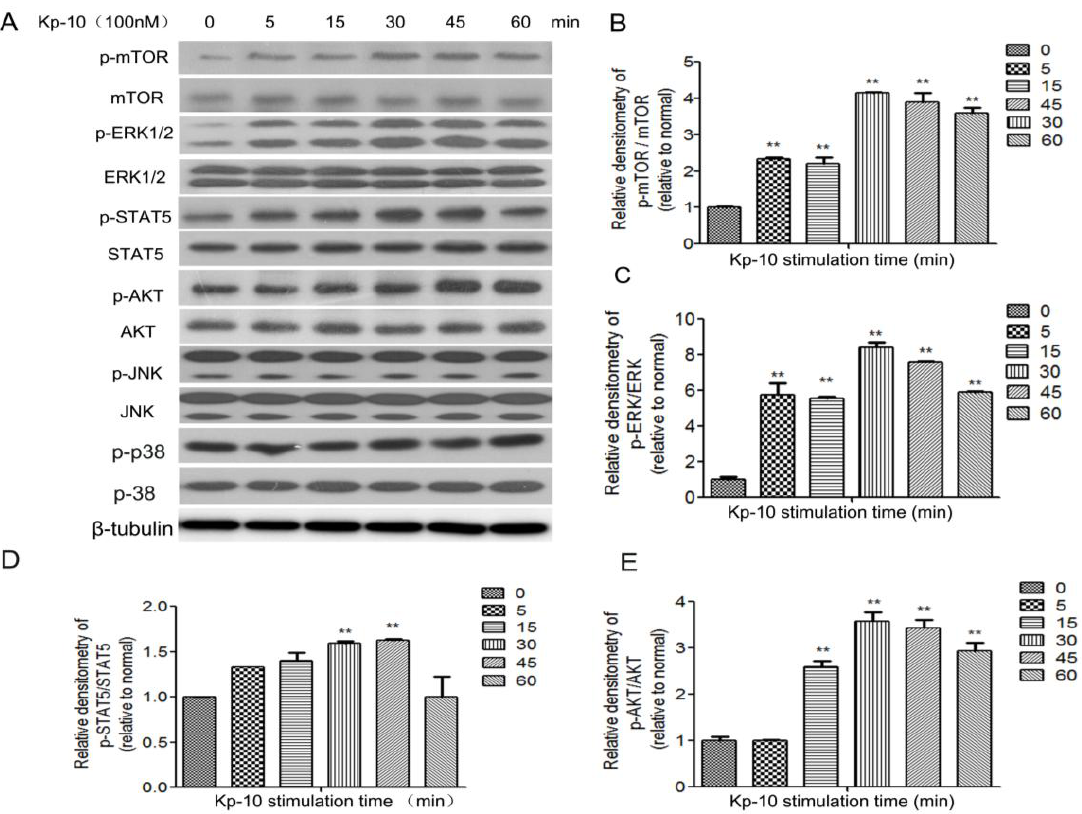
Figure 5. Kp-10 phosphorylates mTOR, ERK1/2, STAT5 and AKT in bMECs. BMECs were serum-starved for 4 h before treatment with Kp-10 (100 nM) over 60 min. ( A ) At the indicated timepoints, cell lysates were prepared and subjected to Western blot to detect the expression of MAPKs, mTOR, STAT5 and AKT. The phosphorylation ratio of mTOR ( B ); ERK1/2 ( C ); STAT5 ( D ); and AKT ( E ) was quantified. The ratio of the control group band (Kp-10 no treatment) was set to 1.00. The data is expressed as the means ± S.D. ( n = 3; ** p < 0.01 vs. NT).